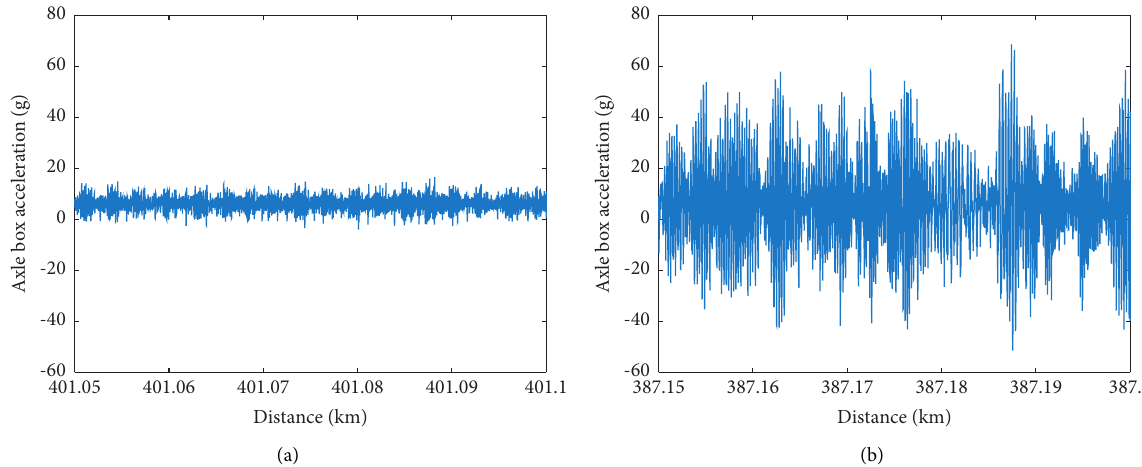
Figure 6: The plots of the axle-box acceleration signal for (a) the normal rail sections and (b) the corrugation rail